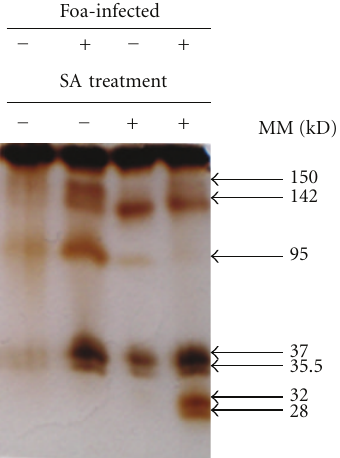
Figure 4: SDS-PAGE of peroxidase activity in roots of date palm Jihel cultivar visualized using DAB staining in response to treatment by salicylic acid (100 μ M) and inoculation with Fusarium oxysporum f. sp. albedinis at the 15th day after inoculation (RM: relative electrophoretic